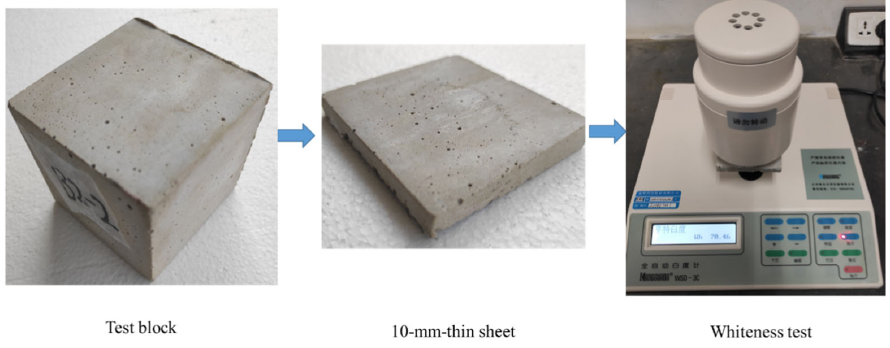
Figure 4. Protocol of testing the whiteness of concrete.